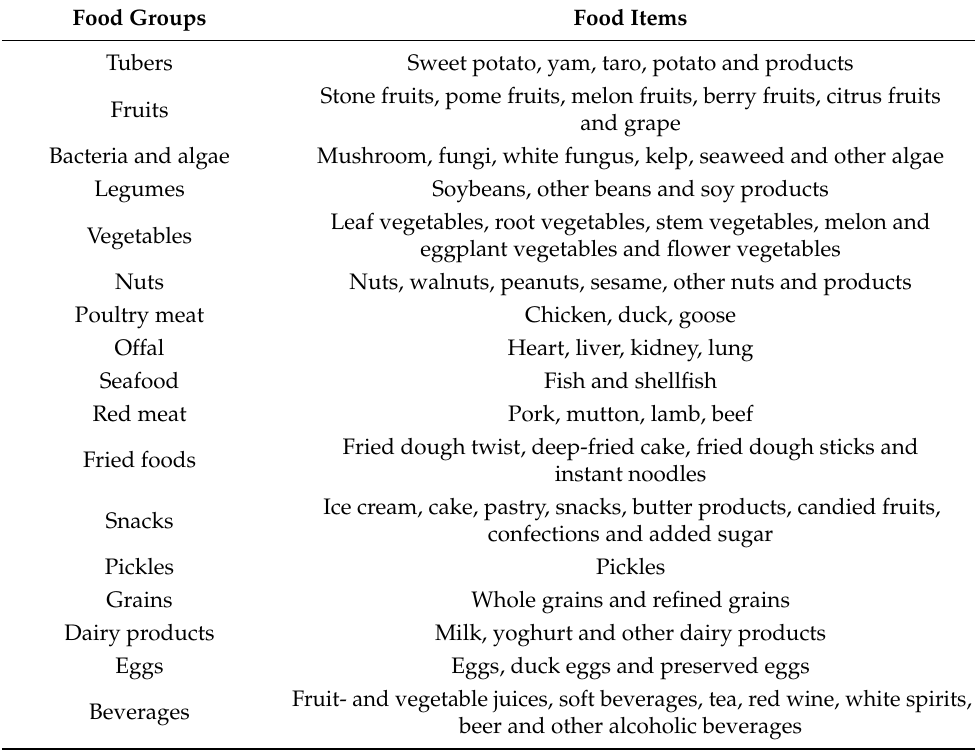
Table 1. Food grouping using in the dietary pattern